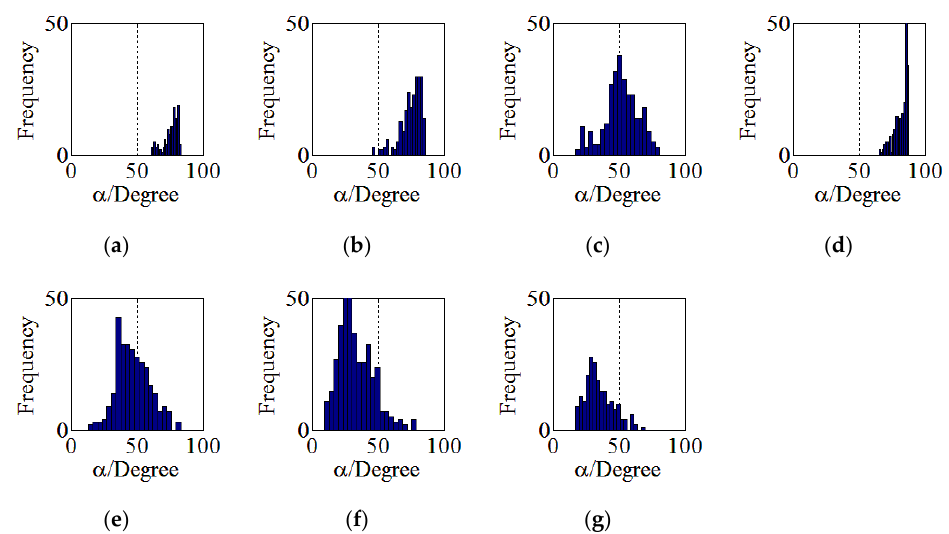
Figure 7. Histograms of DF for chaff clouds. ( a ) Case 1. ( b ) Case 2. ( c ) Case 3-1. ( d ) Case 3-2. EP